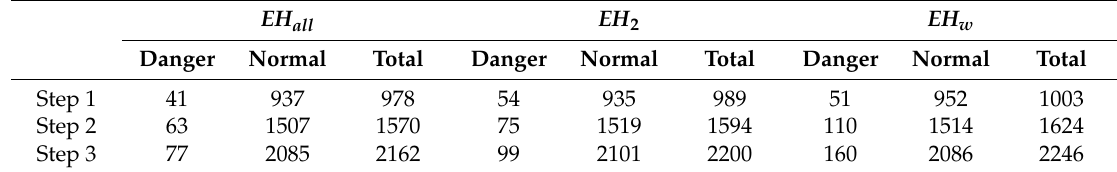
Table 5. New training dataset for enhancing the learning